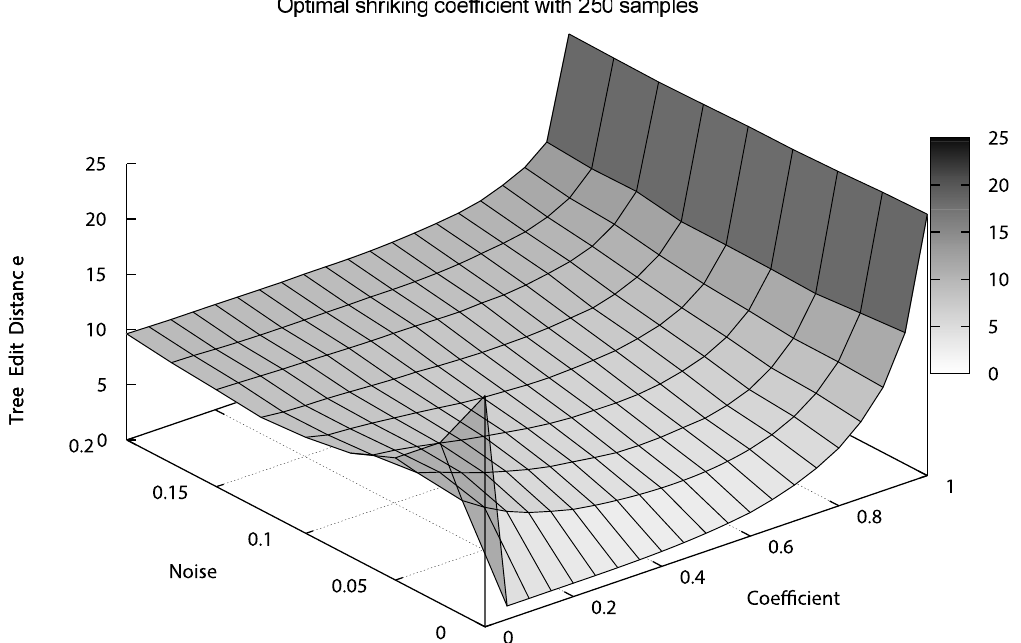
Figure 3. Optimal l with datasets of different size. We show the analogous of Figure 2 with 50 and 250 samples. The estimation of the optimal shrinkage-like coefficient l appears to be irrespective of the sample size.